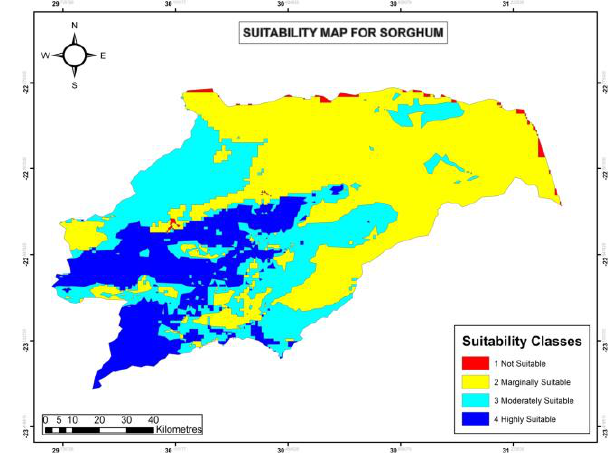
Figure 7. Suitability map for sorghum; Source: Authors